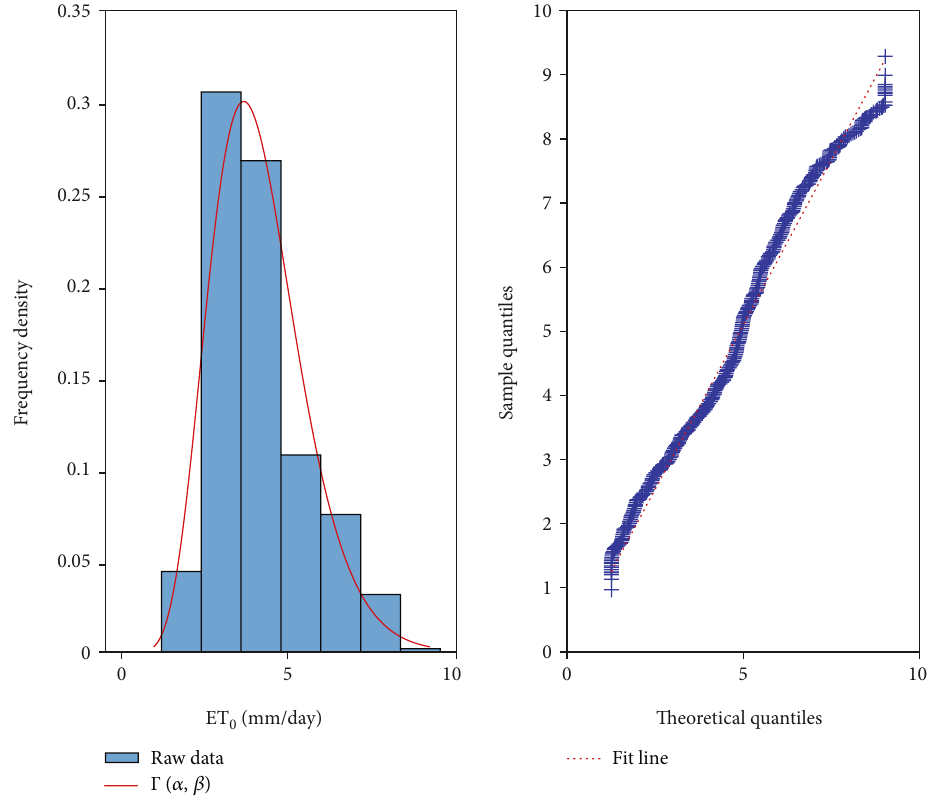
Figure 2: Probability density for E